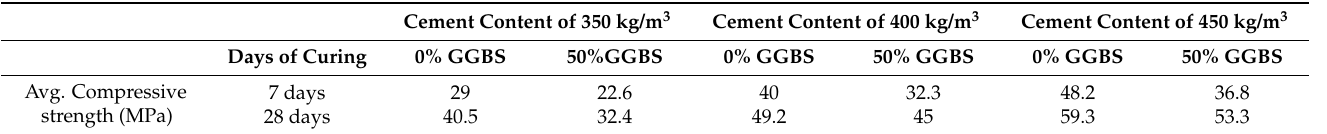
Table 8. Compressive strength with different GGBS and cement ratios (Adapted from [8]).